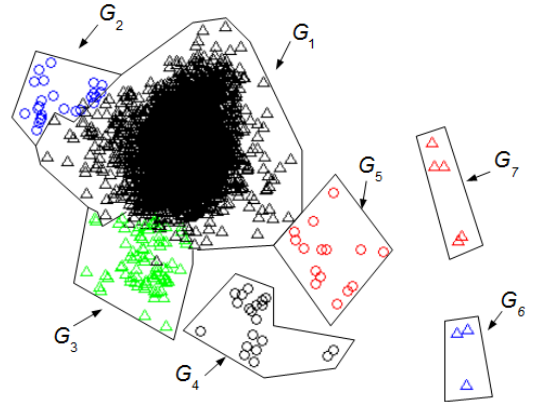
Figure 3. Groups of intervals found using the unsupervised classification (UMED) and a PCA. The L wH has 155 samples. The first two principal components contain 55% of the full information. The different clusters are characterized but not identified. Table 3. Number of intervals per group using the UMED with L wH = 155 samples.